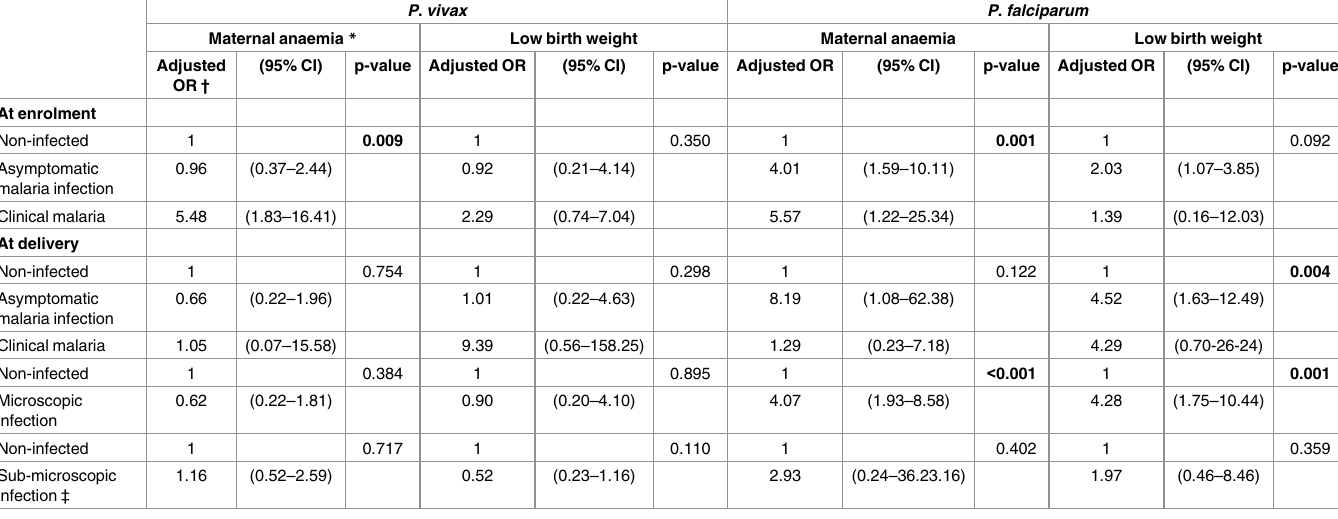
(Table 7). In contrast, those women with clinical malaria at delivery, whether infected with P . vivax (p = 0.754) or P . falciparum (p = 0.122), did not show an increased risk of anemia at the same time point compared to non-infected or infected-asymptomatic women. No Table 7. Impact of P . vivax and P . falciparum malaria on maternal anemia and low birth weight. P . vivax P .